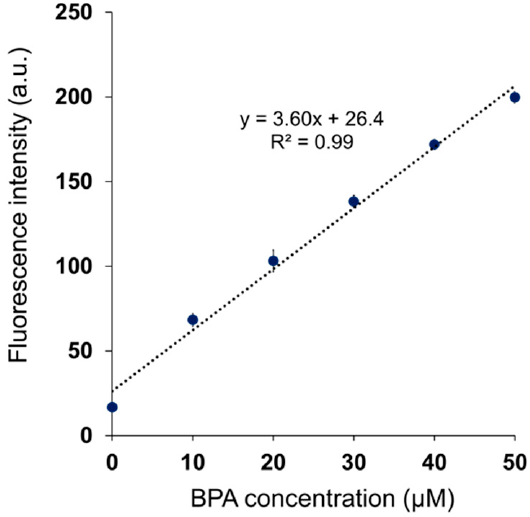
Figure 4. Linear regression analysis between the fluorescence intensities of BITQ (1.0 µ M) and BPA concentrations treated (0–50 µ M) in 0.5% DMSO/H 2 O. ( λ ex = 390 nm, λ em = 480 nm).